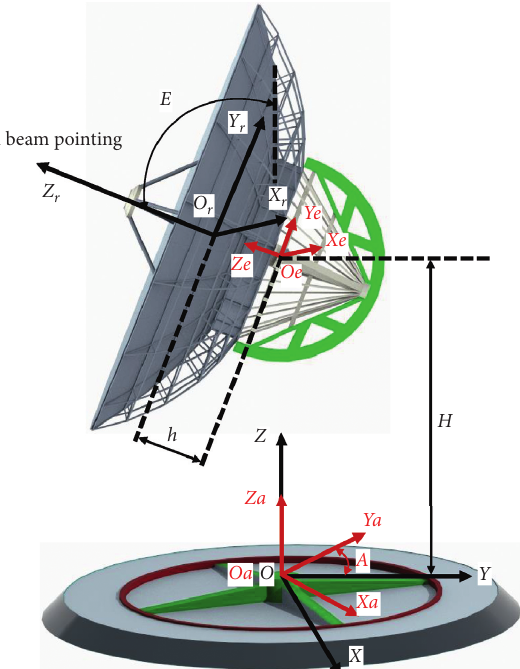
Figure 3: The established coordinates system in the large telescope